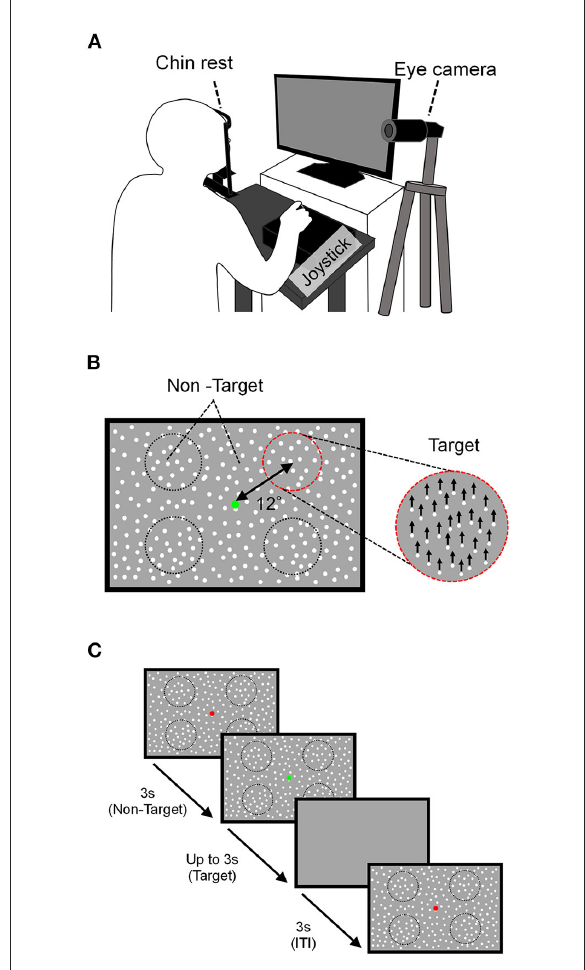
FIGURE1 Schema of the MDD task. (A) The experimental setup. The participant placed his/her head on a chin rest 57cm in front of the LC display and responded to the direction of movement of the target using a joystick. Right eye movements during the task were recorded using a USB camera. (B) Stimulation composition. The target area was a circle (dotted line) and was presented at four locations centered on a point 12 ◦ away from the fixation point. The motion direction of the target stimulus was either up, down, left, or right, which is upward in this example. (C) Task sequence. After non-targeted stimuli are presented with a red FP for 3s, the color of the FP turned green, the target stimulus was presented for up to 3s, and after 3s of ITI, the next attempt